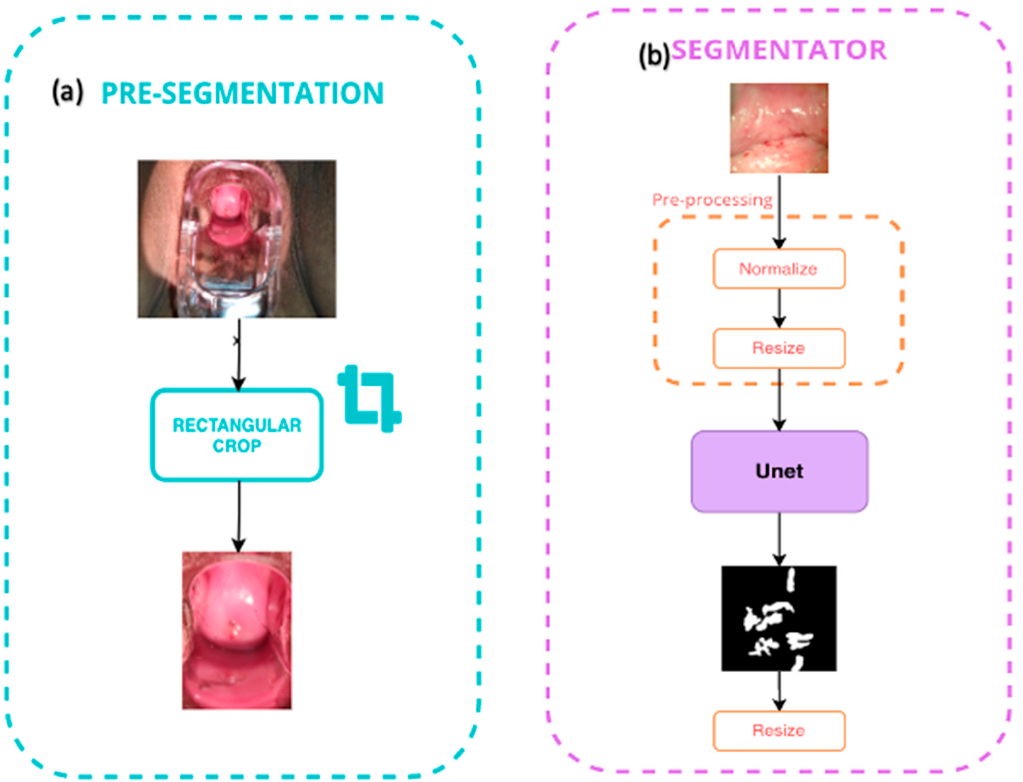
Figure 4. ( a ) Pre-segmentation block; ( b ) segmentation block.